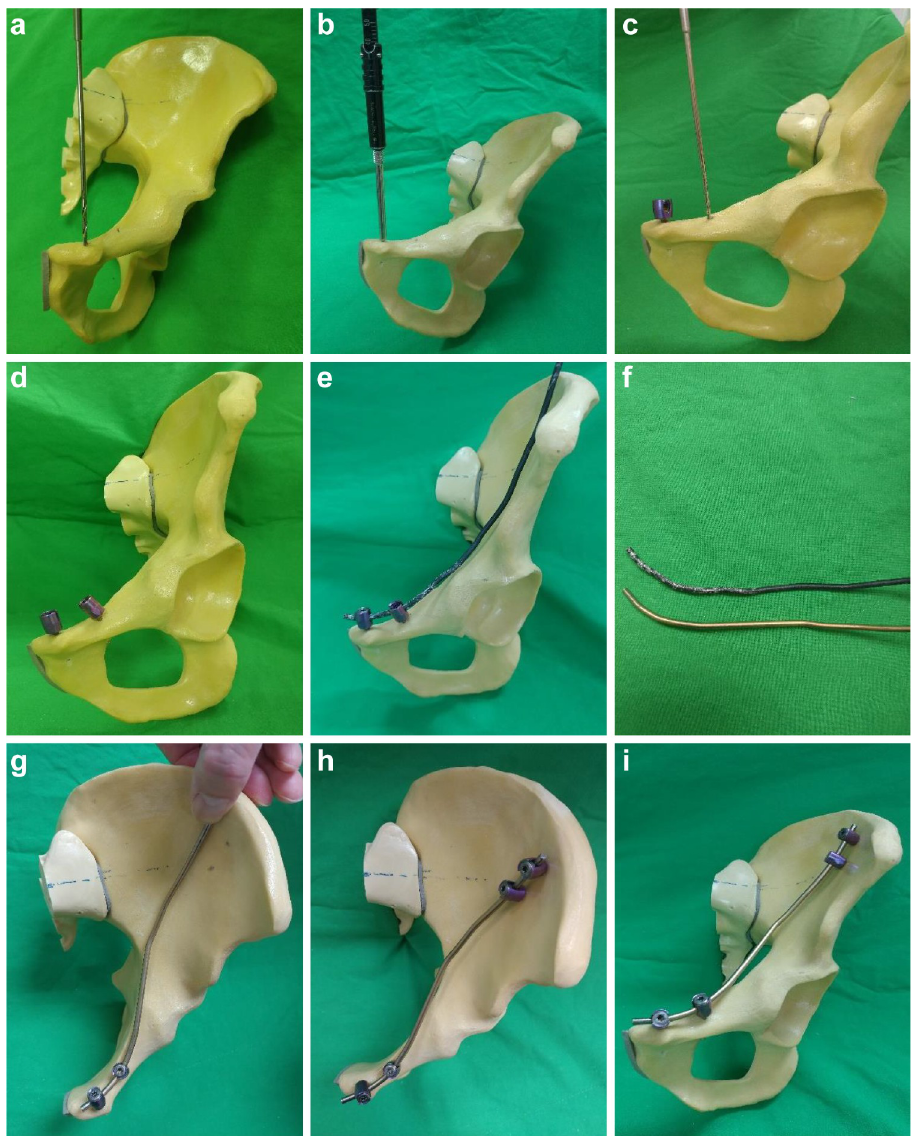
Fig 1. Surgical steps of modified pedicle screw-rod fixation (MPSRF) on a sawbone model. (a) Drilling the pedicle screw hole on the superior pubic ramus. (b) Gauging the screw length and 3.5-mm pedicle screw application. (c) Drilling the second screw hole; in our MPSRF method, two pedicle screws on the superior pubic ramus are needed. (d) Two 3.5-mm polyaxial pedicle screw are inserted. (e) Passing the rod template through the submuscular tunnel; the template is applied on the 2 pedicle screws to adjust the rod figure. (f) Contouring the connecting rod with the rod template. (g) Temporary application of the rod to determine the remaining two pedicle screw positions over the inner table of the iliac wing. (h) Repeat drilling, gauging, and applying the remaining two 4.0-mm pedicle screws and connecting these pedicle screws with the rod. (i) Post-fixation hemi-pelvic anterior-posterior view.